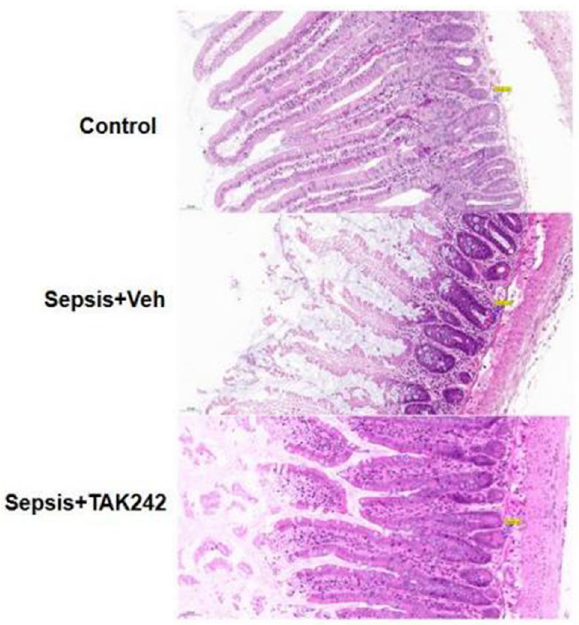
Figure 2. TLR4 caused the damages of intestinal mucosal structure in CLP mouse by Hematoxylin–Eosin staining, including intestinal epithelium degeneration and shedding, villus atrophy and disordered arrangement. Compared to the Sepsis group, TAK-242 treatment had reduced the damages, with a smaller necrotic shedding tissue, small intestinal villi